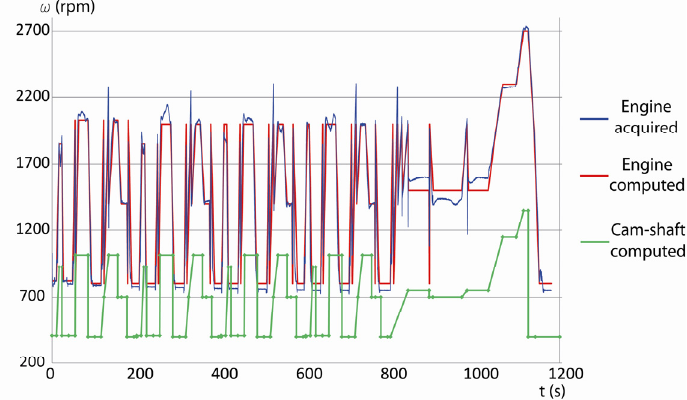
Figure 12: NEDC engine and vacuum pump speed